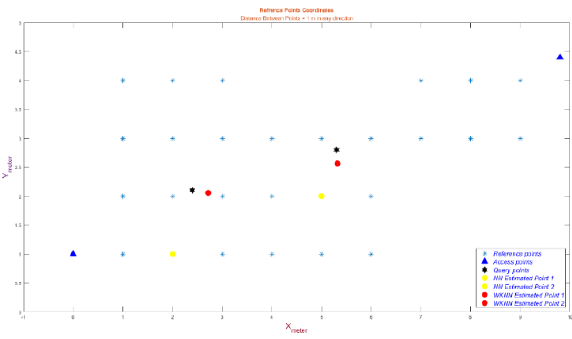
Figure 5 . A view of determining the position of the target points by different methods (NN and WKNN) in the first scenario (Blue stars are reference points, blue triangles are access points, black stars are target points, yellow circles are estimated points from NN method and red circles are estimated points from WKNN method) The target points were obtained by positioning methods, and RMSE was calculated for each method as described in table 2.